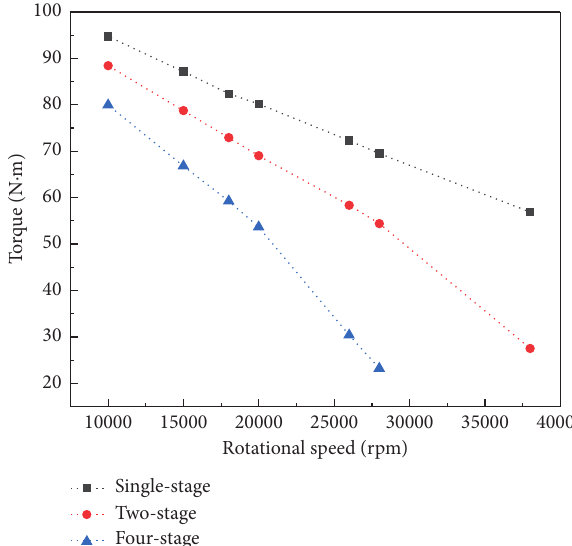
Figure 13: Relationship between output torque and rotational speed of small-size turbines.